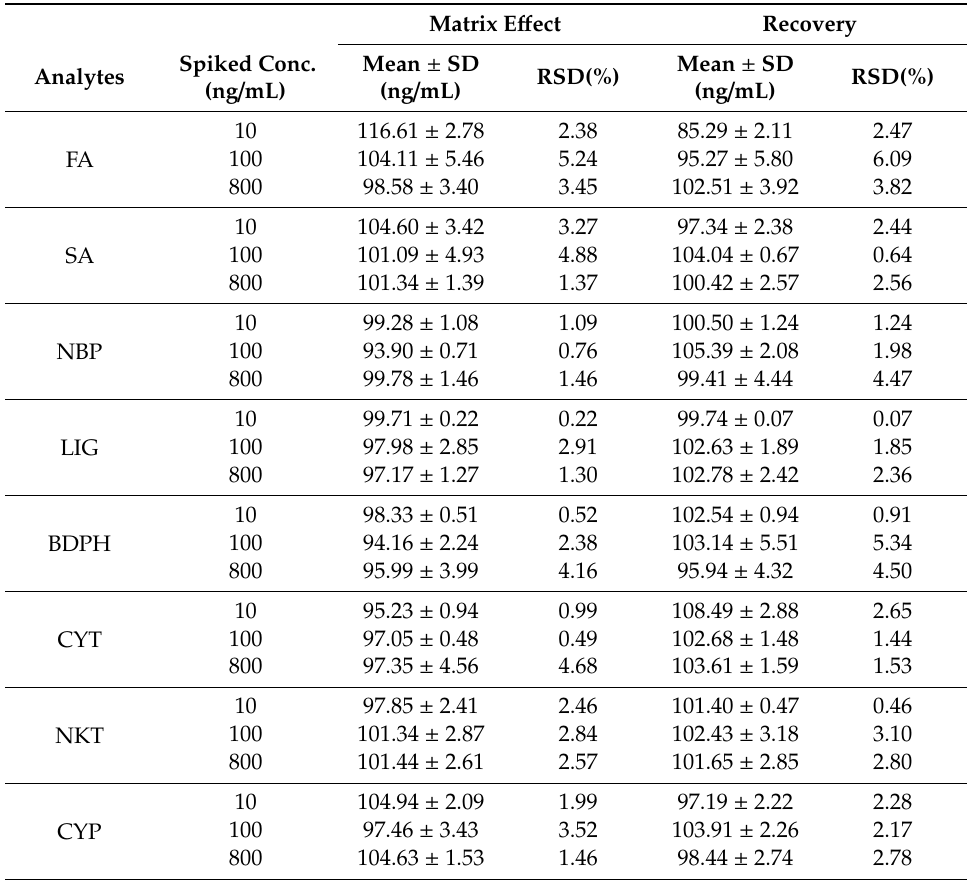
Table 3. Matrix e ff ects and recoveries of the analytes in rat serum ( n = 3). Matrix E ff ect